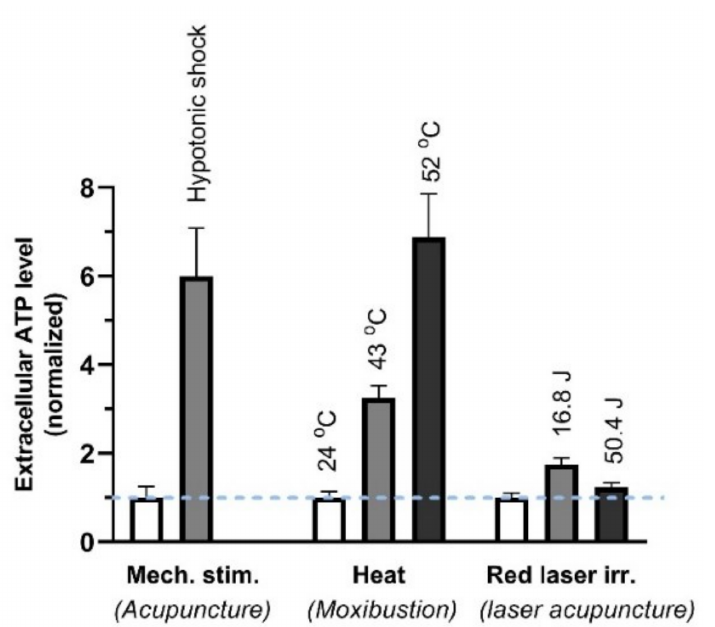
Figure 13. ATP released from MCs (HMC-1 cell line) in response to different stimuli. The cell suspen- sion was perturbed by 3-min, 50% hypotonic shock (of acupuncture), 3-min heat (of moxibustion) or irradiation of 657-nm laser irradiation (280 mW/cm 2 ) (of red laser acupuncture). Energy density (J/cm 2 ) = power density (W/cm 2 ) × time (s). The data represent averages + SEM ( n = 4–16) and are based on Wang et al. (2013) and Wang et al. (2015) [46,73].